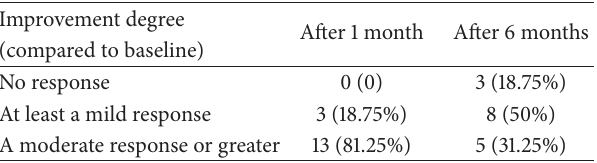
Table 3: Improvement degree (compared to baseline) at one month and 6 months after the beginning of the